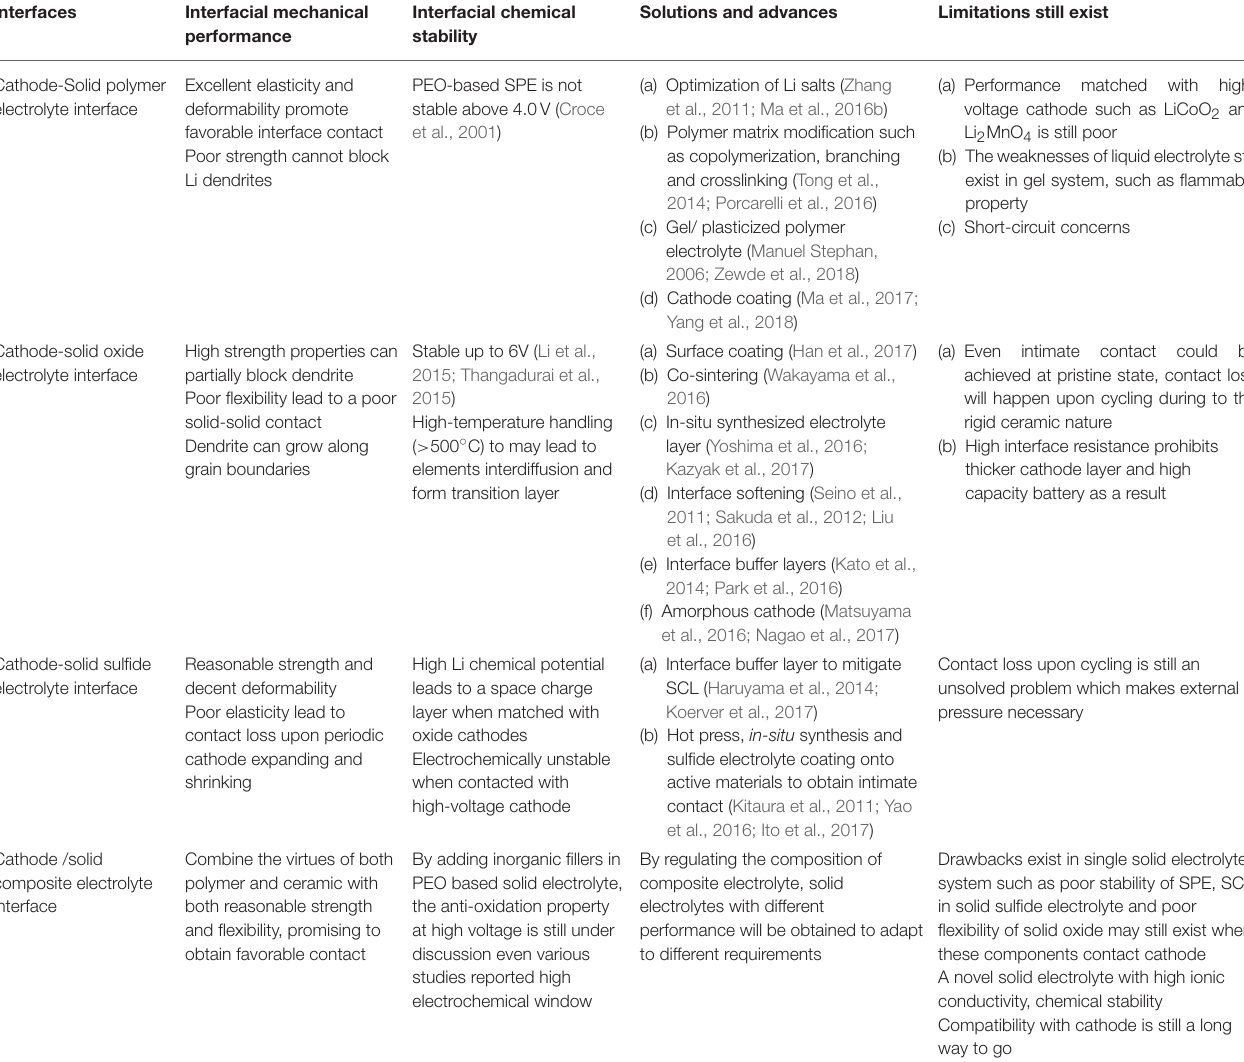
TABLE 1 | Interfacial challenges exist in cathode-solid electrolyte systems according to the different characteristics of the four types of solid electrolytes and the corresponding solutions, recent advances and limitations still exist.